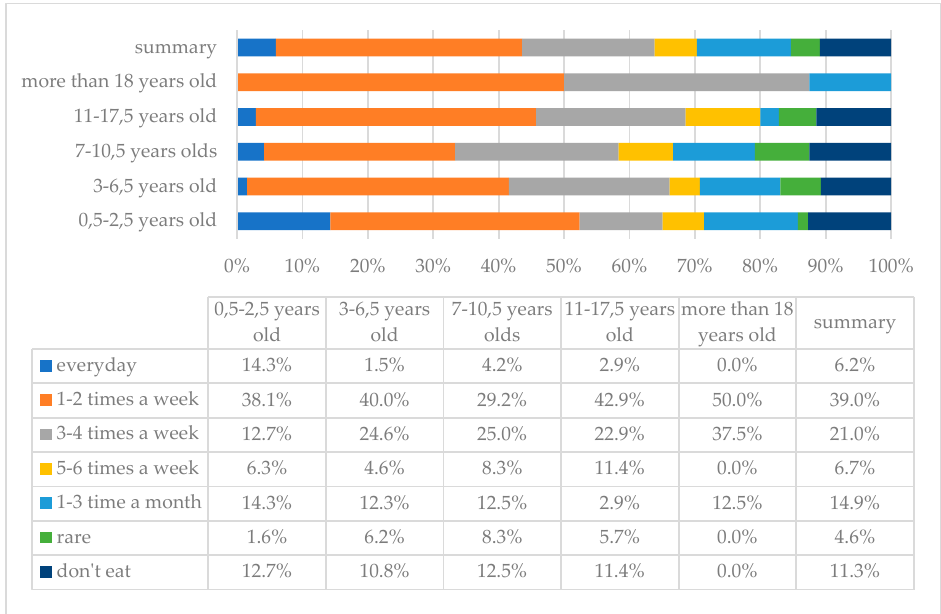
Figure 3. Frequency of dairy intake in the study group of individuals with DS by age. Eggs are a rich source of protein and contain many vitamins. The analysis showed that eggs are most often eaten 1–2 times a week; this answer was indicated by 76 (39%) parents, while 22 (11.3%) answered that their children do not eat these products at all (Figure 4).